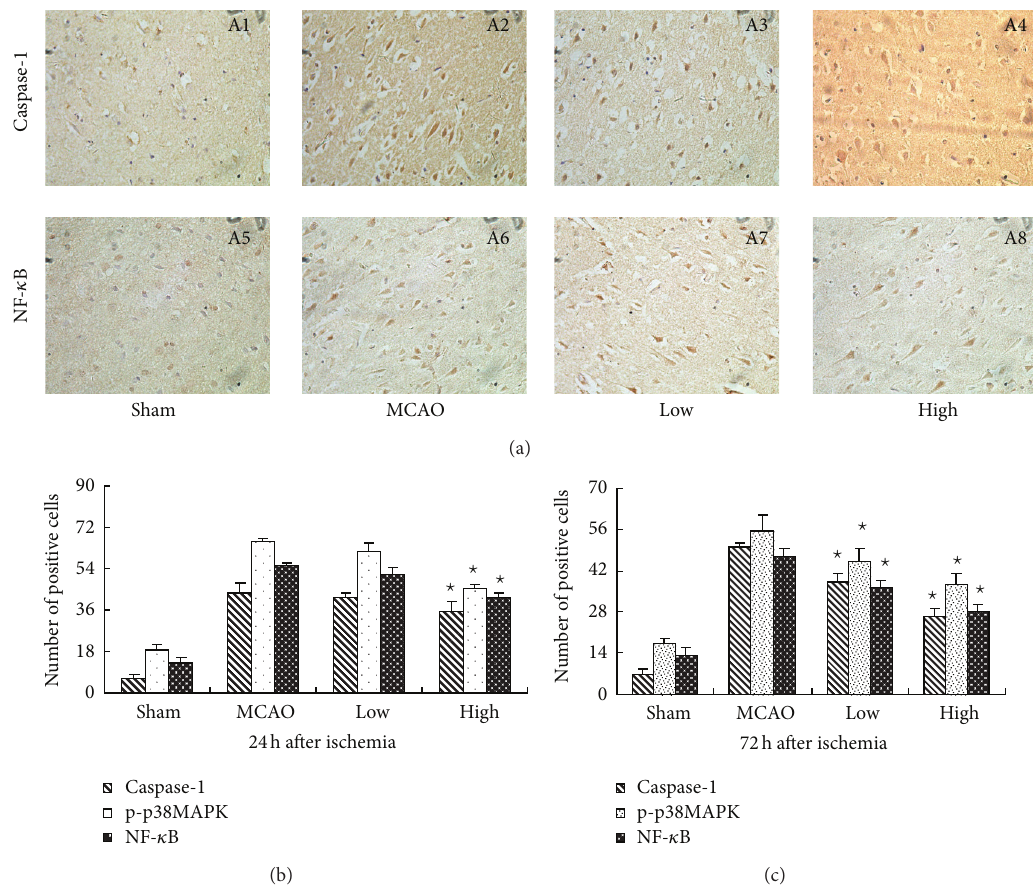
Figure 3: PN decreased the positive cells of caspase-1 and NF- 𝜅 B after MCAO. (b) and (c) shows the positive cells of caspase-1, phospho- p38MAPK, and NF- 𝜅 B. Compared with MCAO group, the number of positive cells of caspase-1, phospho-p38MAPK, and NF- 𝜅 B was significantly decreased in High group at 24 h and 72 h, but only at 72h in Low group after MCAO ⋆ 𝑃 < 0.05 versus MCAO group. Representative photographs in (a) show the expression of caspase-1 (A1, A2, A3, A4) and NF- 𝜅 B (A5, A6, A7, A8) at 72h after ischemia